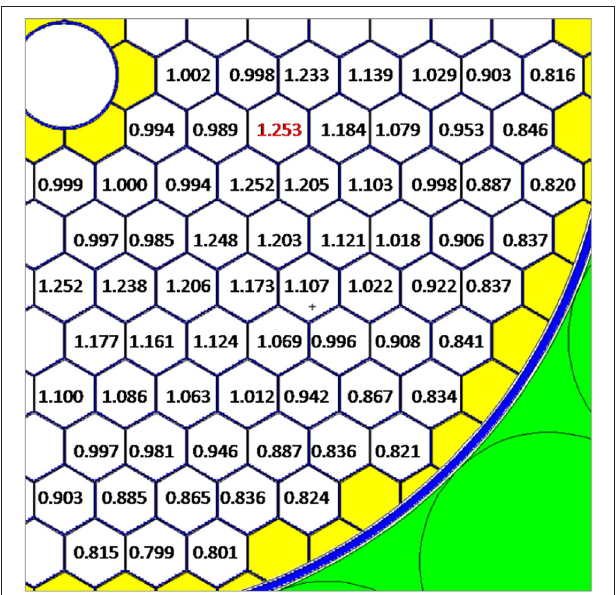
FIGURE 7 | Calculation scenario when a set of control rod is stuck facing outboard of the core.